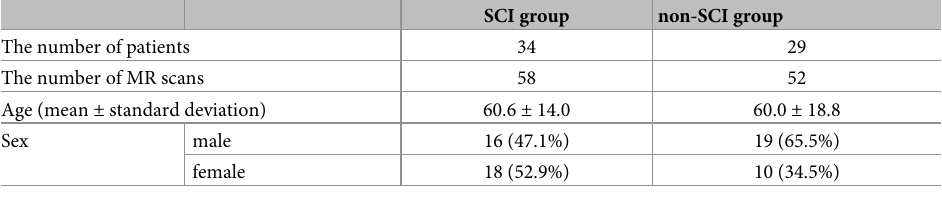
female 18 (52.9%) 10 (34.5%) SCI, spinal cord